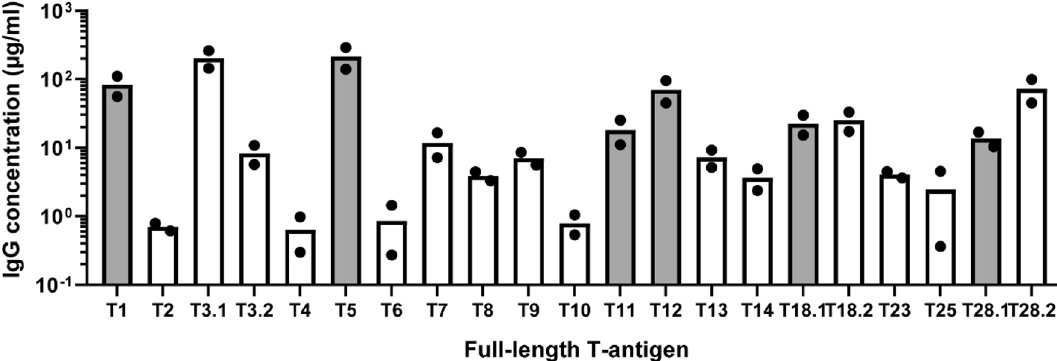
Figure 2. Serum antibody responses to TeeVax1 in rabbits. Sera from rabbits (n = 2) immunised with TeeVax1 were analysed by ELISA. IgG concentration to each specific T-antigen was interpolated using a known standard. Each biological replicate is plotted (circles), with bar representing the mean IgG concentration. Grey bars represent T-antigens present in the TeeVax1 construct and white bars represent T-antigens absent in TeeVax1.